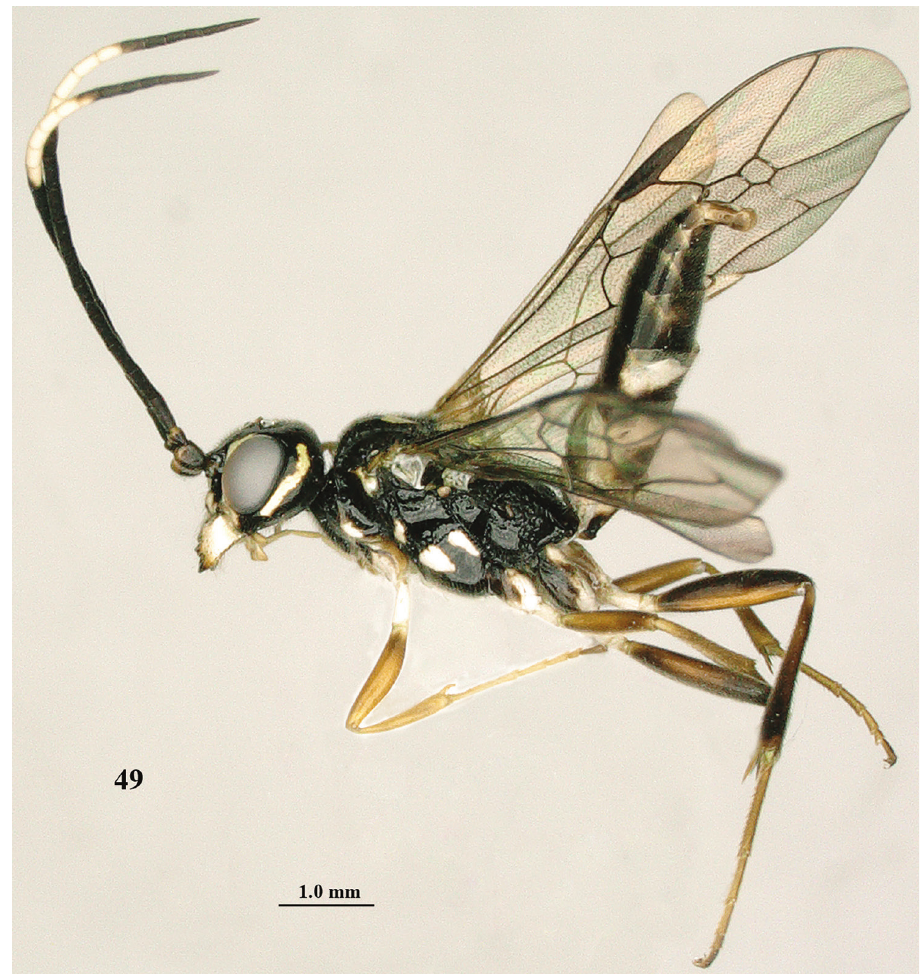
Figure 49. Orthogonalys hirasana Teranishi, male, Shaanxi (Shanshuping), habitus lateral.